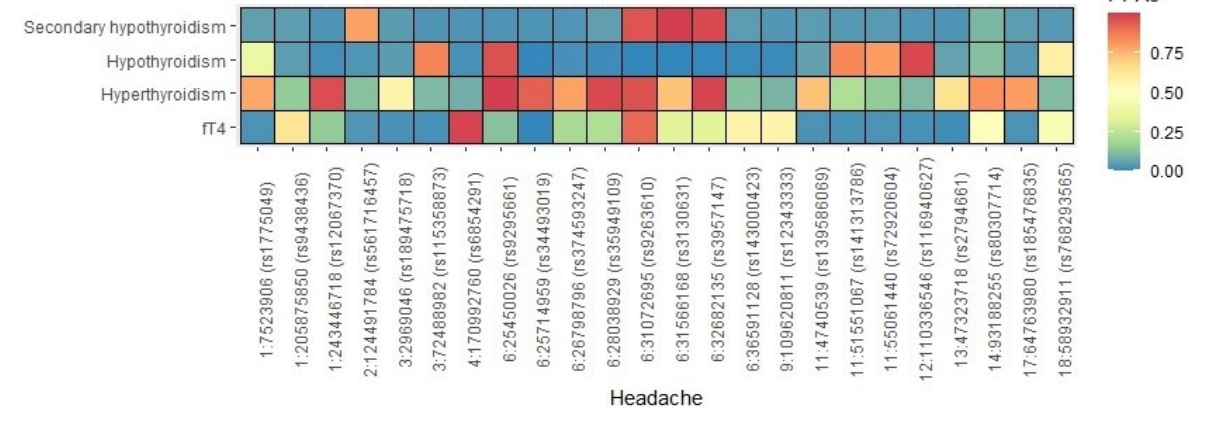
Figure 1. GWAS-PW comparisons with headache and thyroid traits. Pleiotropic loci represented by the lead (most significant) SNP (and its chromosome and base pair position) reaching a PPA3 > 0.5 from GWAS-PW analysis of headache and thyroid traits (hypothyroidism, hyperthyroidism, sec- ondary hypothyroidism, and fT4). SNP, single nucleotide polymorphism; GWAS-PW, pairwise GWAS; PPA3, posterior probability of association.